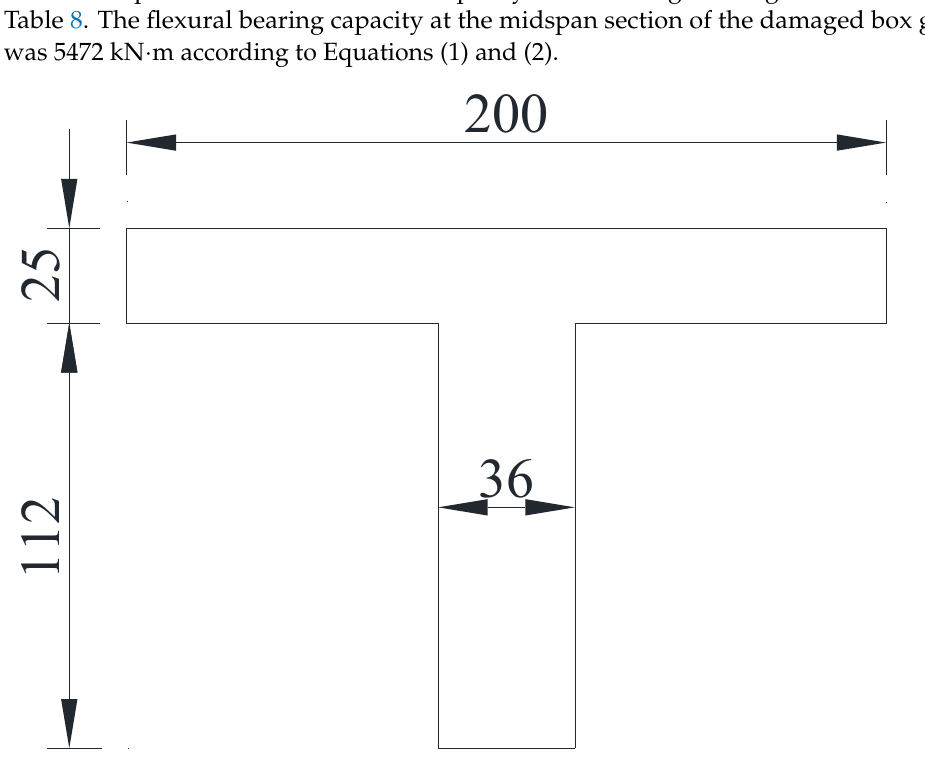
Figure 14. Equaled T-shape of the damaged girder (Unit: cm). Table 8. Calculation parameters of normal section flexural capacity of the damaged box